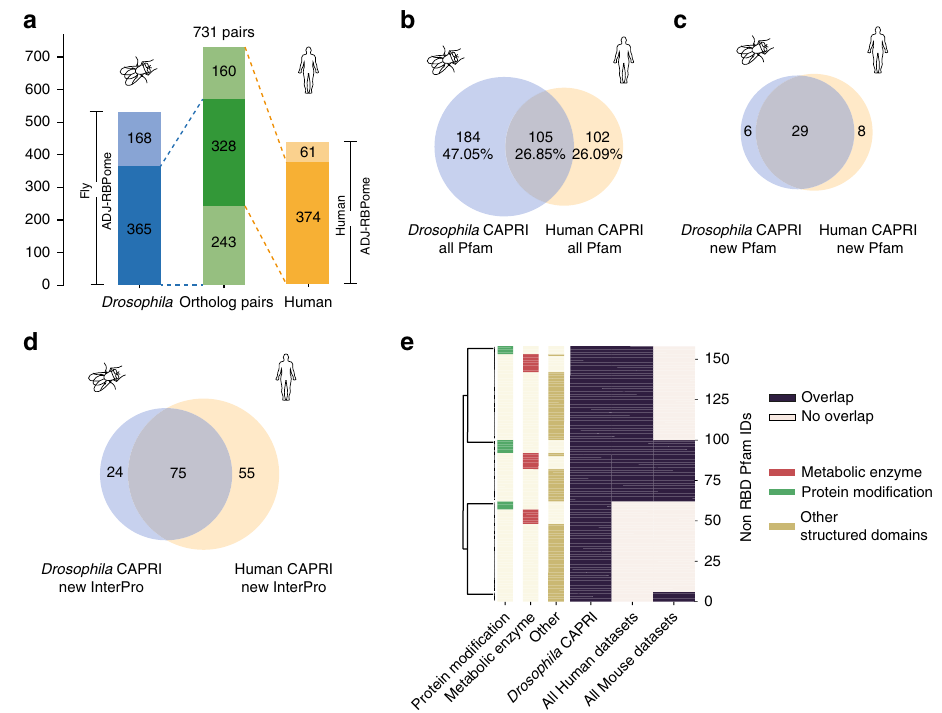
Fig. 7 Conservation of RBDs between human and Drosophila proteins. a Mapping of proteins identi fi ed by ADJ-peptides in Drosophila (left) and humans (right) onto DOIPT ortholog pairs (centre). Proteins with no orthologs are noted by the lighter shade of colour in each of the species columns. b Overlap of all identi fi ed Pfam domains in Drosophila (blue) and humans (yellow). c Overlap of new Pfam domains in orthologous proteins identi fi ed in both species. d Overlap of new InterPro domains in orthologous proteins identi fi ed in both species. e Clustered heatmap representing all the non-RBD Pfam domains identi fi ed in Drosophila using the CAPRI protocol together with the identi fi cation of the same domains in all human (CAPRI, RBDpep[21] and pCLAP[40]) and mouse (RBDpep and RBR-ID[22]) protocols. The domains are manually annotated as belonging to three categories: metabolic enzymes, domains involved in protein modi fi cation and the remaining structured